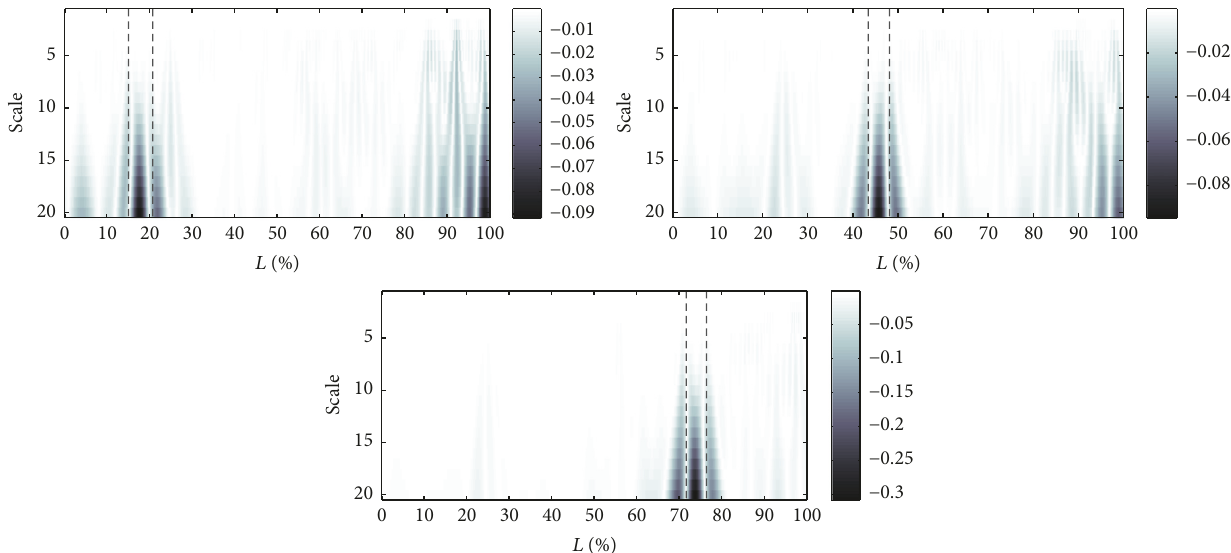
Figure 20: Scalograms of differential signals (damaged to reference) obtained for the 9th mode of natural vibrations for three damage